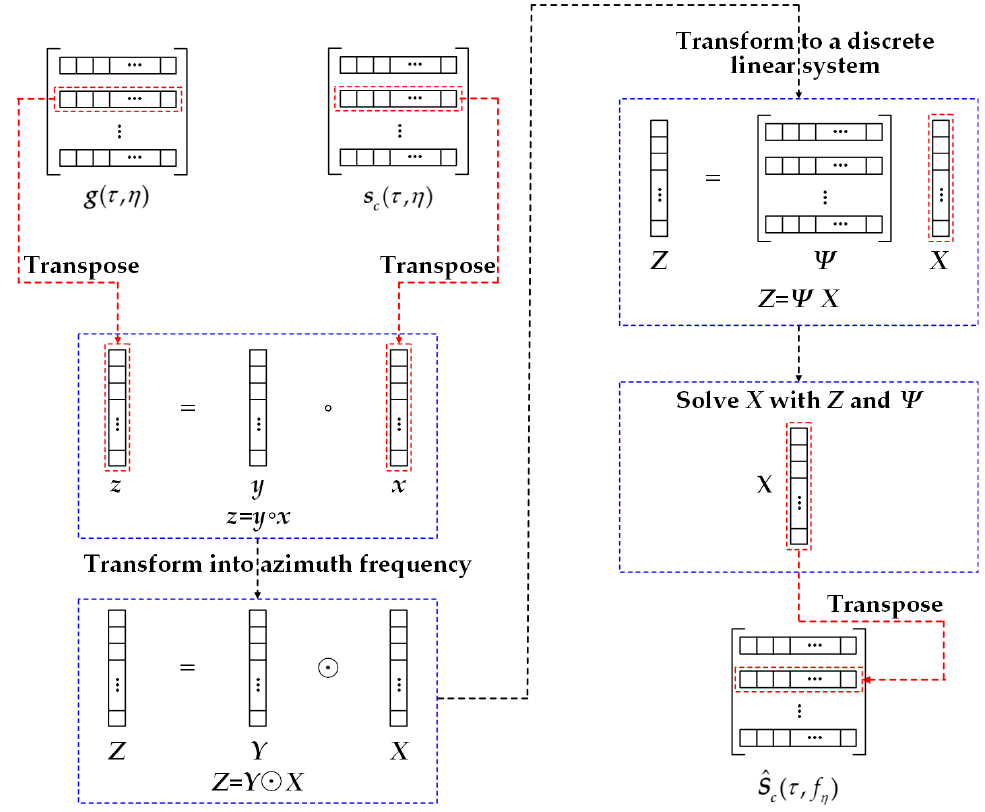
Figure 8. Procedure of restoration via complex